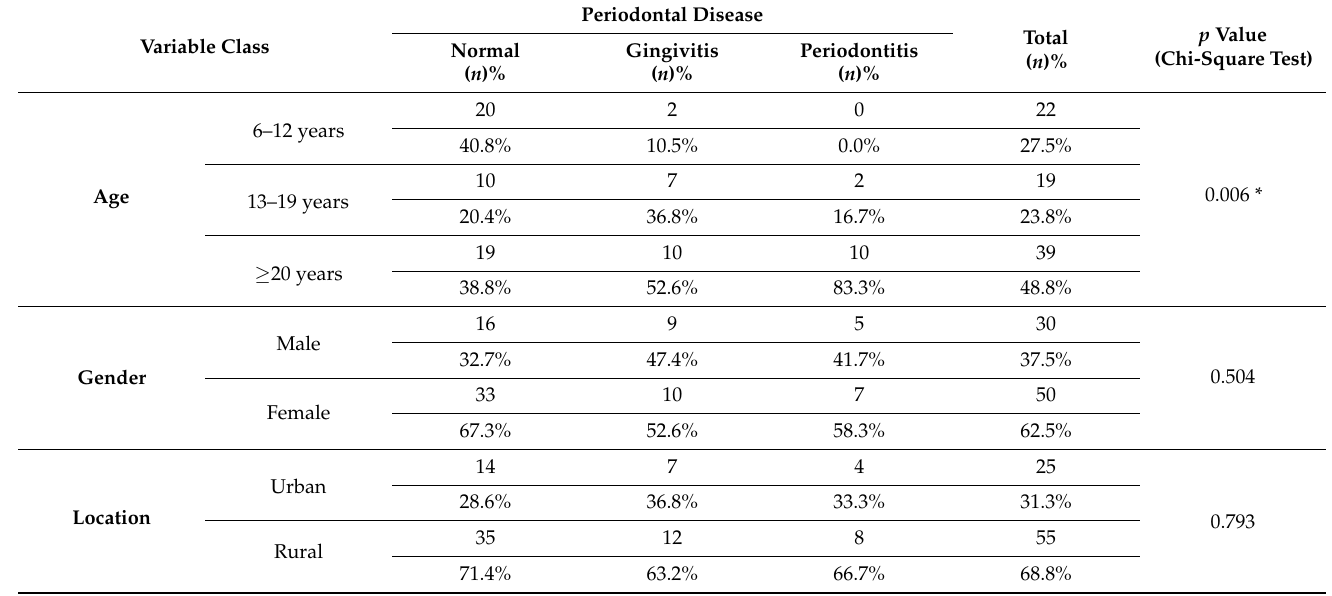
Table 1. Demographic characteristics of the participants.